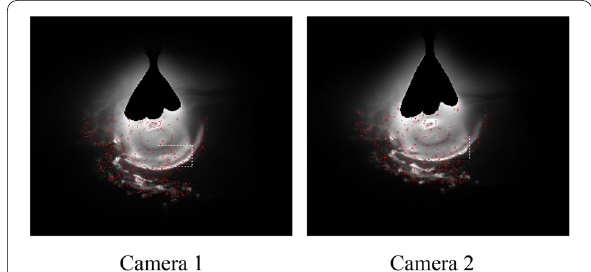
Figure 9 KAZE feature points of the welding pool image under the arc (240 A, 33 V, 0.6